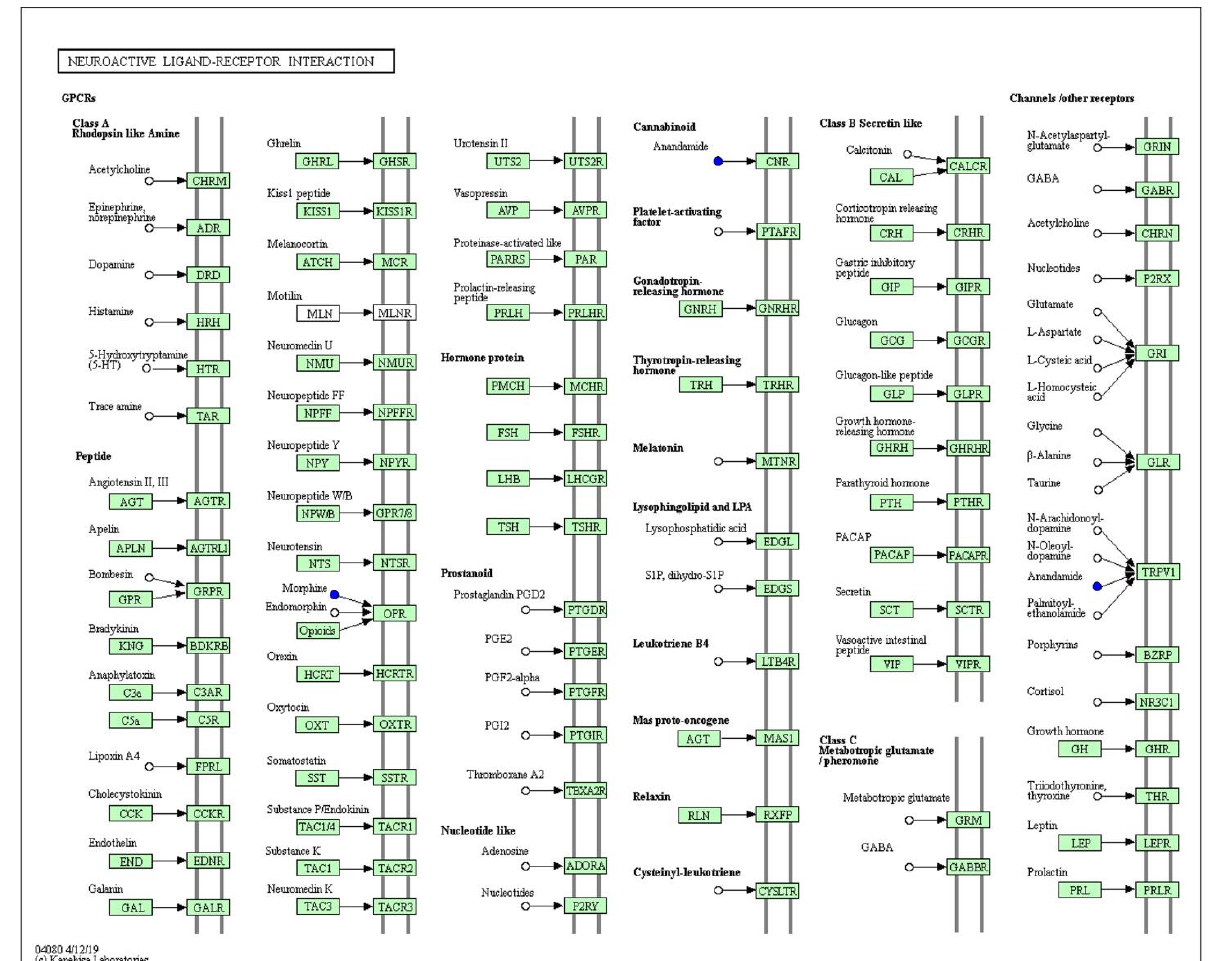
Figure 8. Prediction of metabolic pathway in mice before and after intervention with LZU-J-TSL6 . The KEGG metabolic pathway analysis diagram – metabolic pathway of neuroactive ligand-receptor interaction.